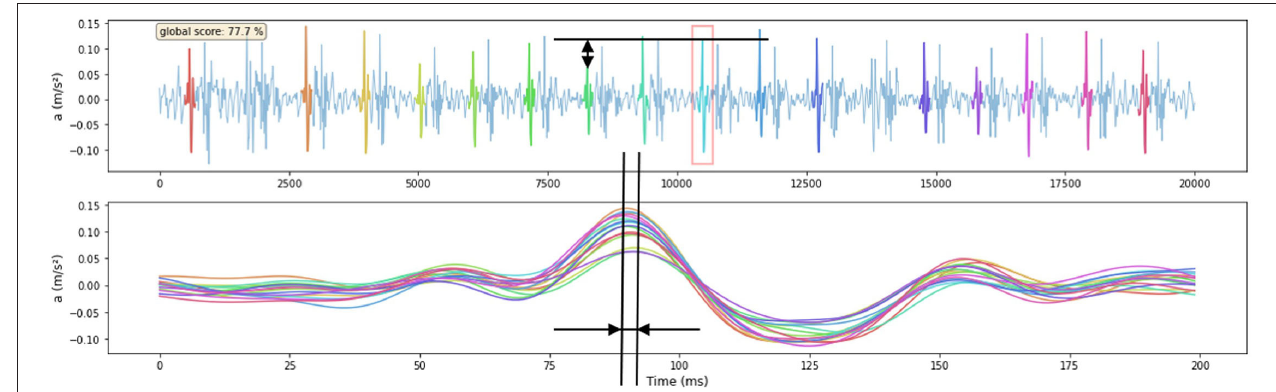
FIGURE 8 | Example of one signal being scored by the features that are derived from the Matrix-Profile-identified motif. The amplitude feature of one subsequence is shown in the upper figure, the reference is indicated with a red square. The time-instant of subsequence peak feature is shown in the lower figure where all subsequences shown in the upper figure are time-aligned. The signal score is shown in the upper left corner of the upper figure. The visual score of this signal is 4.